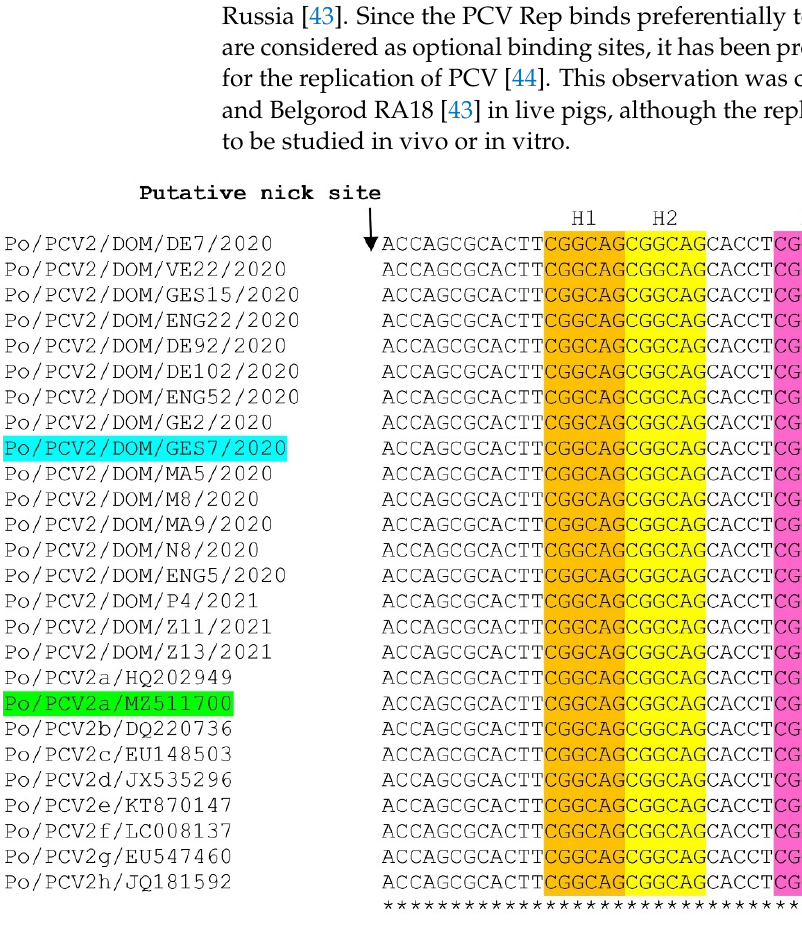
Figure 1. Multiple alignment of the partial origin of replication ( ori ) sequences (downstream of the putative nick site) of porcine circovirus 2 (PCV2) strains from the Dominican Republic (host/virus species/country/virus name/year) with those of reference PCV2 strains (host/PCV2 genotype/GenBank accession number). The four hexamer repeats, H1-4, are highlighted with orange, yellow, pink, and gray, respectively. A unique 11-nucleotide (nt) deletion (shown with red) was observed in the putative ori sequences of PCV2 strain GES7 (shown with blue) from the Dominican Republic and PCV2a strain Belgorod RA18 (GenBank accession number MZ511700, shown with green) from Russia. A ‘*’ denotes an identical nt residue, whilst ‘-’ indicates absence of an nt residue. Numbers to the right indicate the positions of the nt for respective sequences.